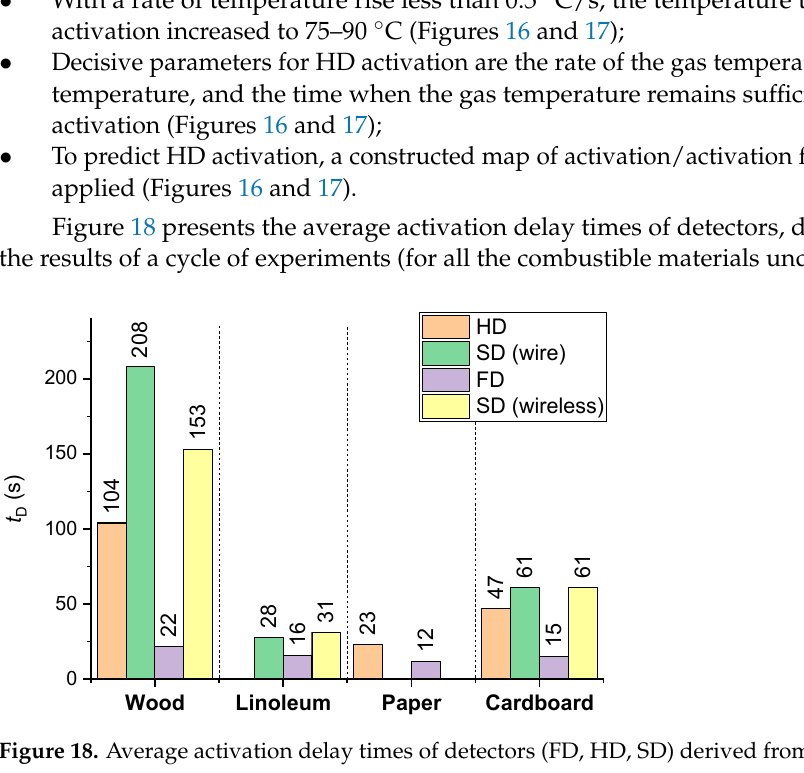
Figure 18. Average activation delay times of detectors (FD, HD, SD) derived from a cycle of experiments (for all the combustible materials under